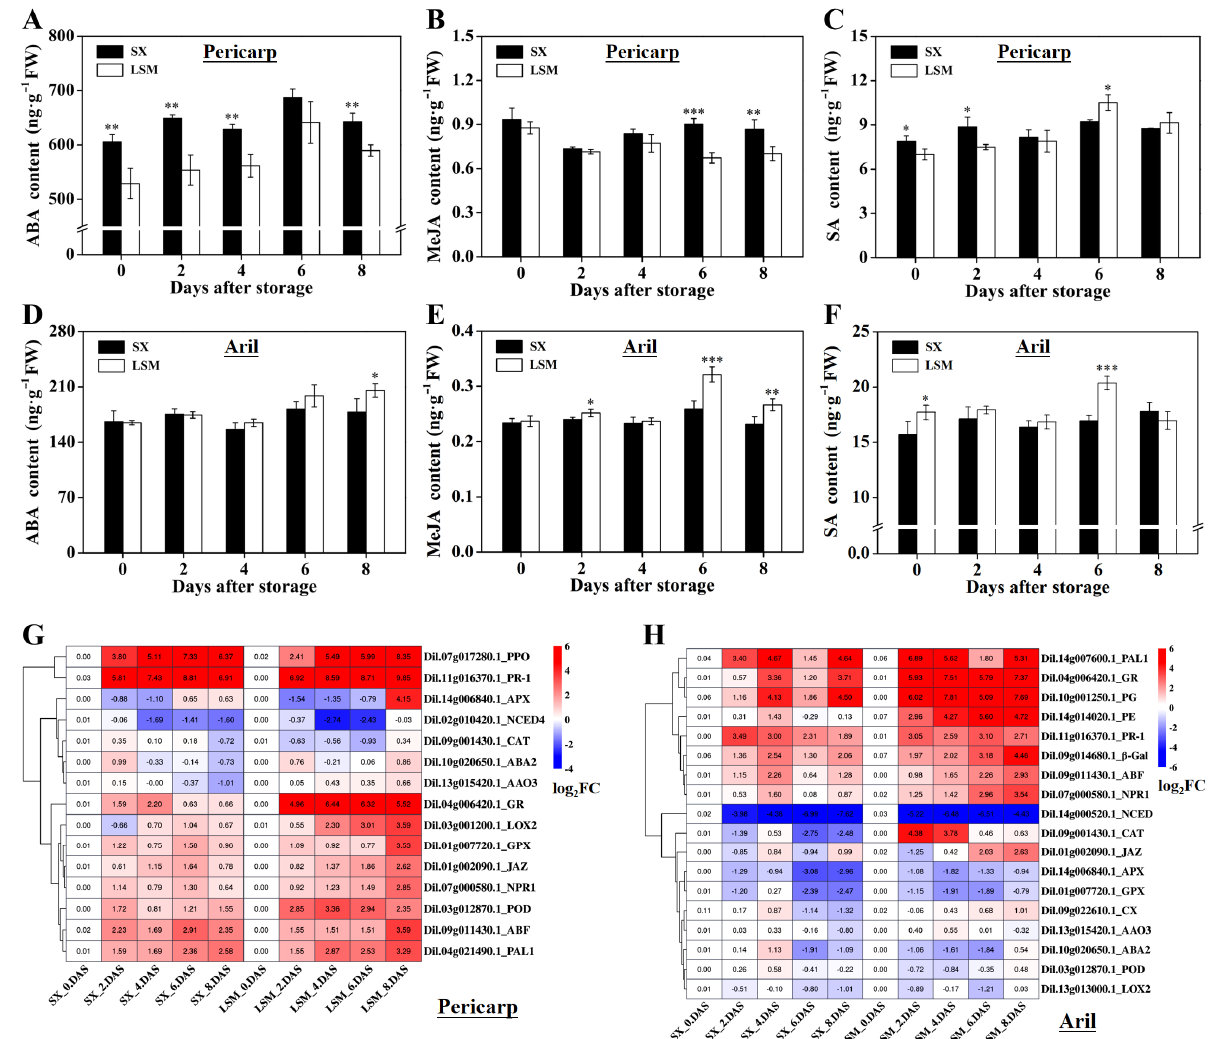
Figure 5. The contents of ABA, JA and SA and the expression of genes related to radical-scavenging, synthesis and signal transduction of hormones in 'Shixia' and 'Luosanmu' longan fruit. ( A ) ABA, ( B ) JA and ( C ) SA content in pericarp; ( D ) ABA, ( E ) JA, and ( F ) SA content in aril; ( G ) Expression of 15 genes related to radical-scavenging, synthesis and signal transduction of hormones in pericarp; ( H ) Expression of 18 genes related to radical-scavenging, synthesis and signal transduction of hormones in aril. *: 0.01 < p < 0.05: **: 0.001 < p < 0.01; ***: p < 0.001. FC: Fold change (expression of the other samples divided by that of SX_0 DAS). Color gradation: red means up-regulated and blue means down-regulated. FW: fresh weight.